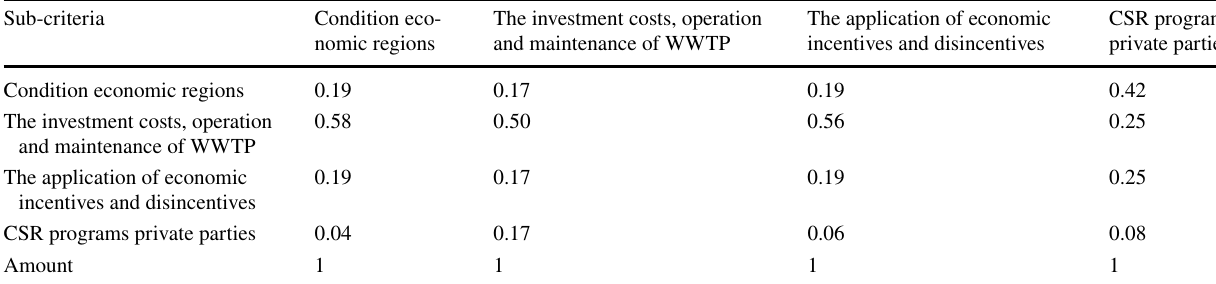
Table 12 Normalization sub-criteria comparison matrix Sub-criteria